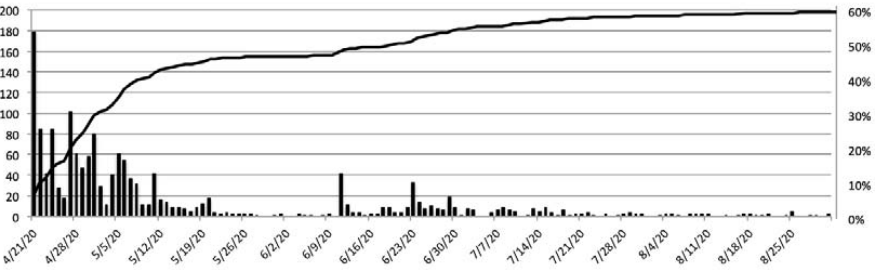
Figure 1. Number of responses per day and total response, NYU CHES COVID-19 questionnaire.